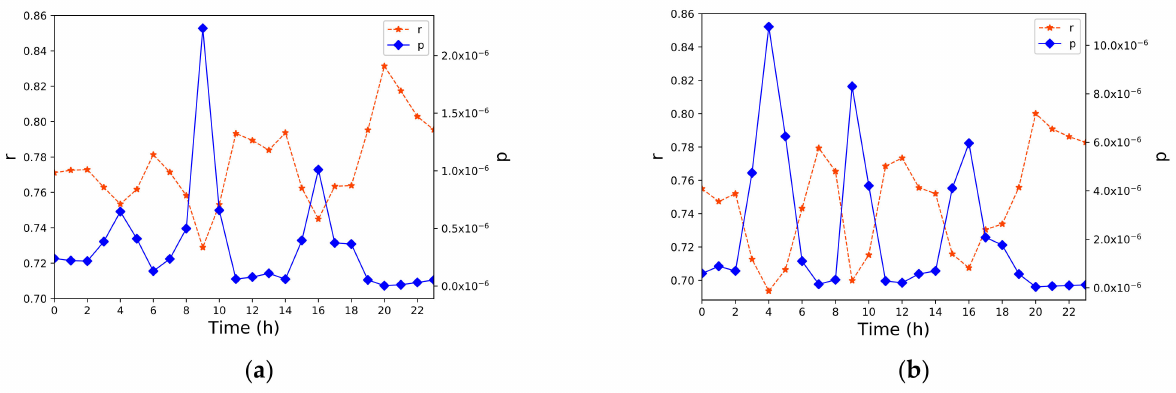
Figure 7. Population correlation analysis for TAZ levels. ( a ) Move population correlation; ( b ) stay population